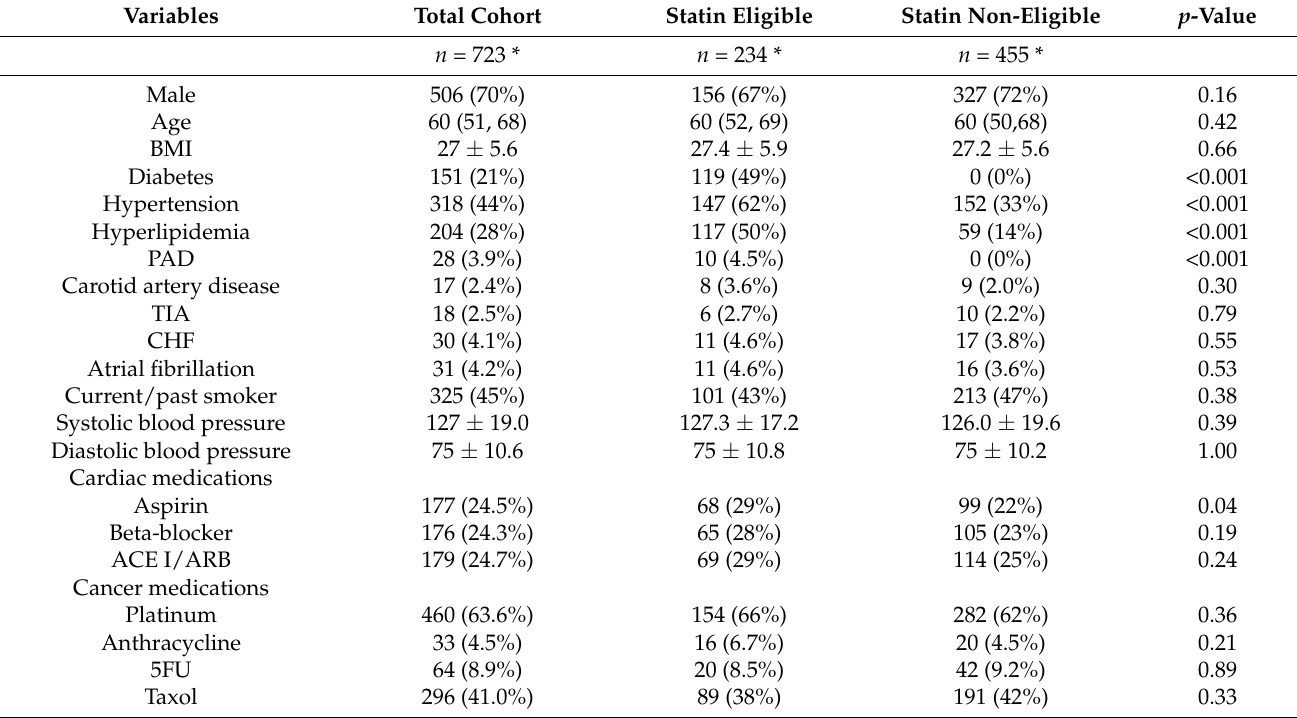
Table 3. Demographics—Comparison of statin eligible vs. statin non-eligible groups based on FRS.